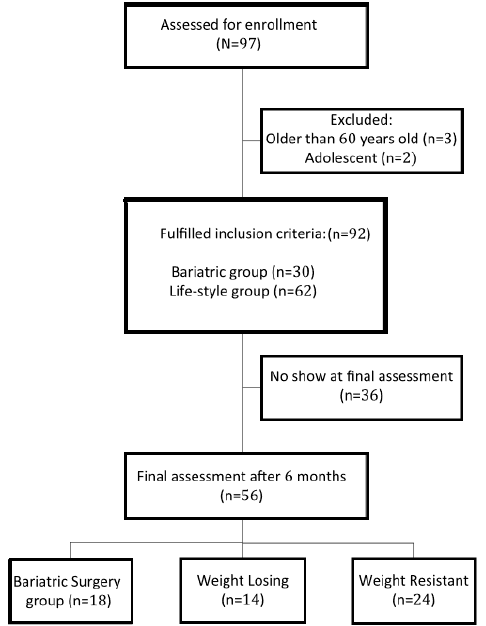
Figure 1. Flow diagram of the progress through the phases of the study.